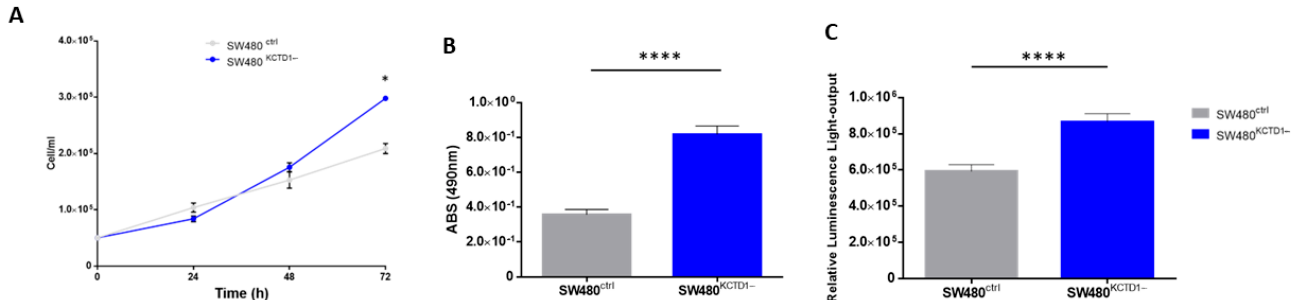
Figure 4. ( A ) SW480 ctrl (grey line) and SW480 KCTD1 − (blue line) cell growth (expressed as cells/ µ L). Cell concentrations are shown as mean +/ − SD of three technical independent experiments. * = p < 0.05. MTT assay ( B ) and ATPlite assay ( C ) of SW480 ctrl (grey bars) and SW480 KCTD1 − (blue bars) after 72 h of growth. **** = p < 0.001. Mann–Whitney t -test. Error bars represent the SD of four independent experiments.